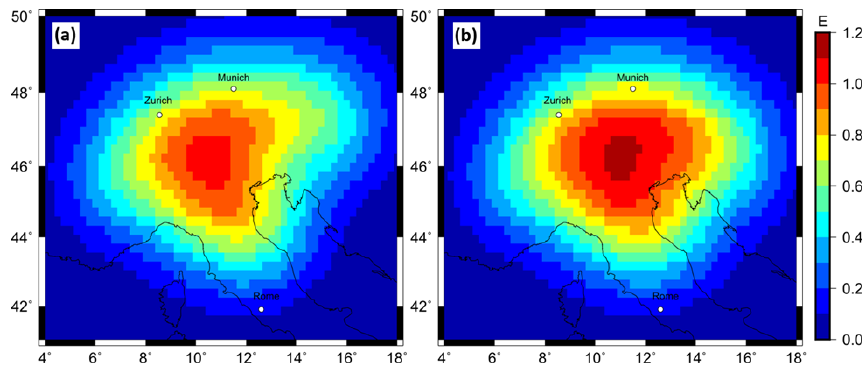
Figure A3. Forward-calculated gzz gravity signal at a station height of 225km from predefined subcrustal slab geometries with a con- tent density contrast of 60kgm − 3 and a constant thickness of 80km. (a) Slab configuration of Configuration 1. (b) Slab configuration of Configuration 2.